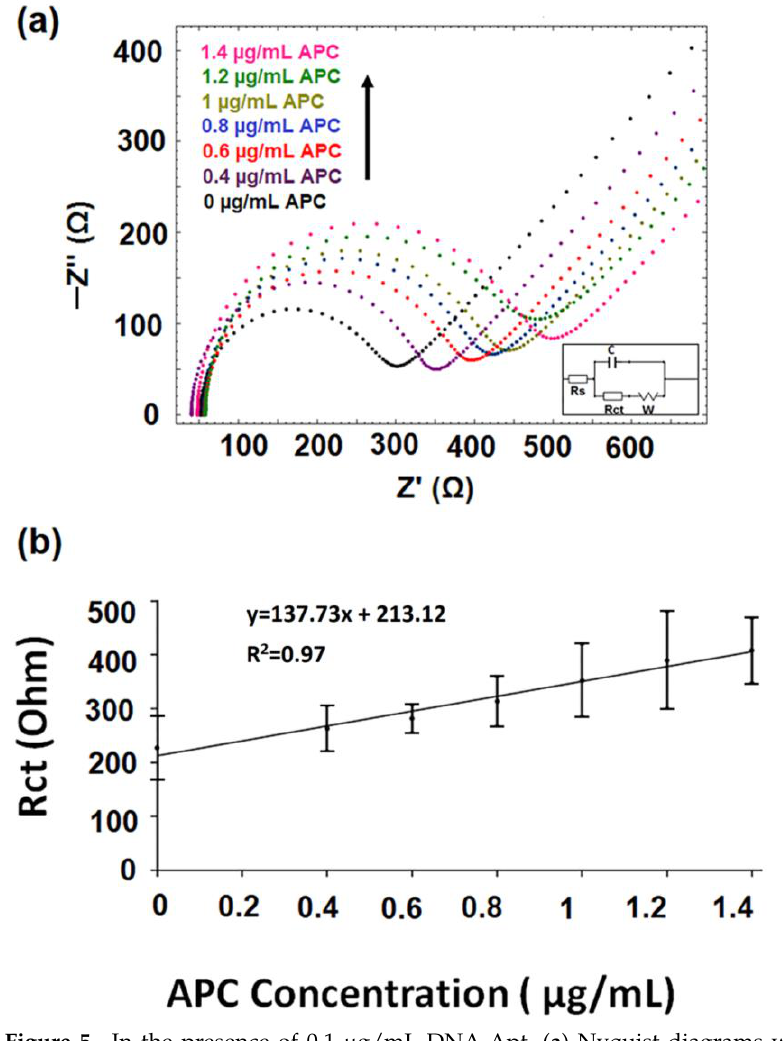
Figure 5. In the presence of 0.1 µ g/mL DNA-Apt, ( a ) Nyquist diagrams were obtained in the absence/presence of APC in its increasing concentrations in buffer medium ( b ) Calibration curve for impedimetric determination of APC in buffer medium.